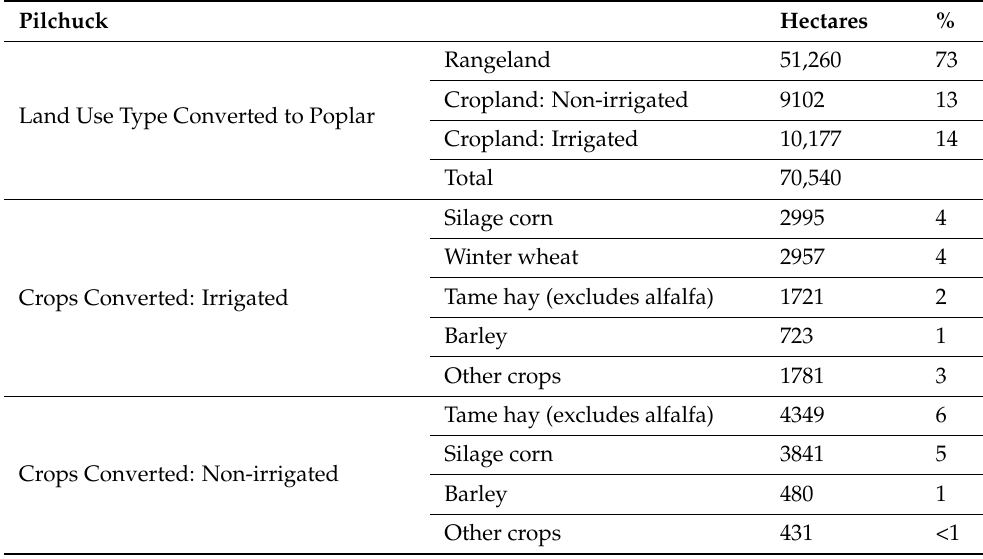
Table 2. Pilchuck land use and crop types converted to growing poplar. ‘Other crops’ are crops that individually represented less than 1% of the land used to grow crops. Percentage column is based on the total land use types converted to growing poplar.